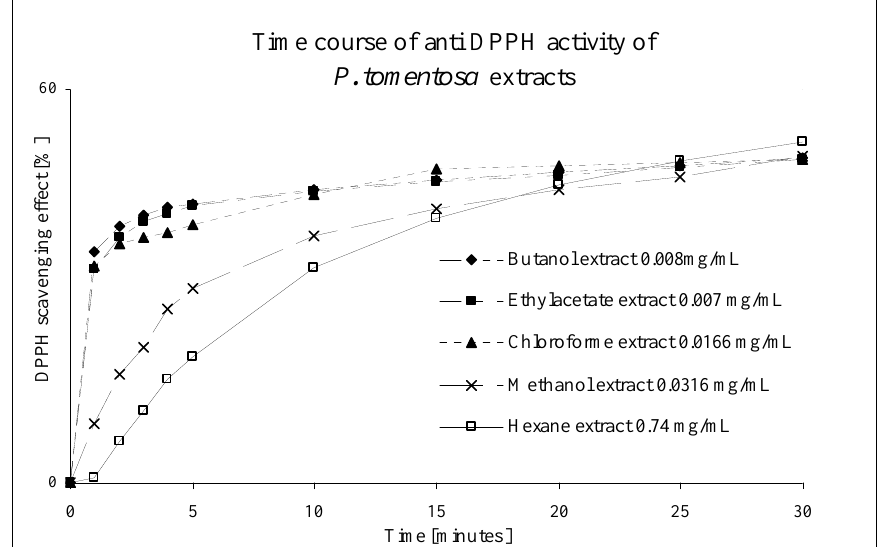
Figure 5 : Time course of the anti DPPH activity of P. tomenotosa extracts. EC concentrations used, values determined from three parallel